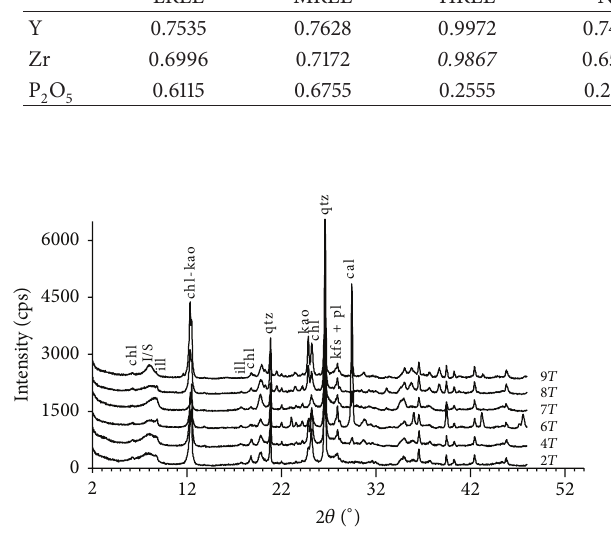
Figure 2: XRD patterns of bulk sample. Chl = chlorite; Kao = kaolinite; Ill = illite; I/S = illite-smectite mixed layers; Qtz = quartz; Kfs + Pl = K-feldspar + plagioclase; Cal = calcite.